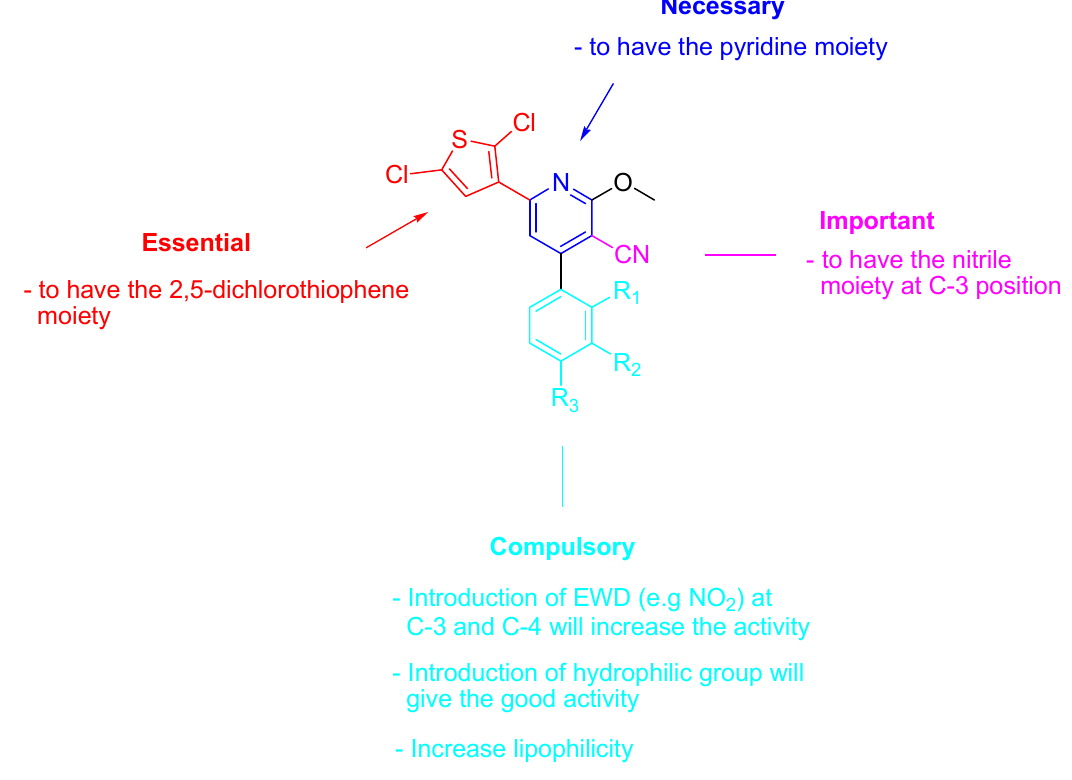
Figure 2. Chemical structure of the pyridine-3-carbonitriles with important sites for the structure– activity relationship (SAR).